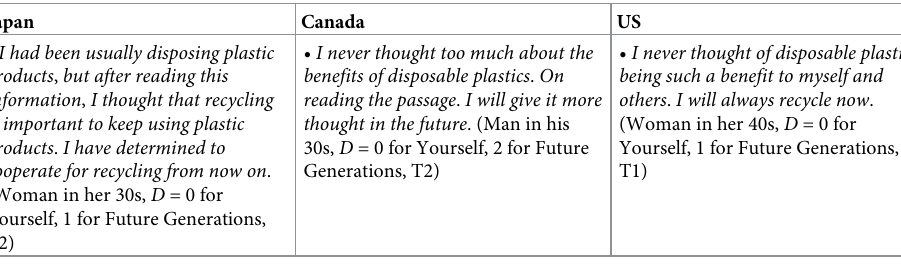
Table 11. Responses suggesting long-term intervention